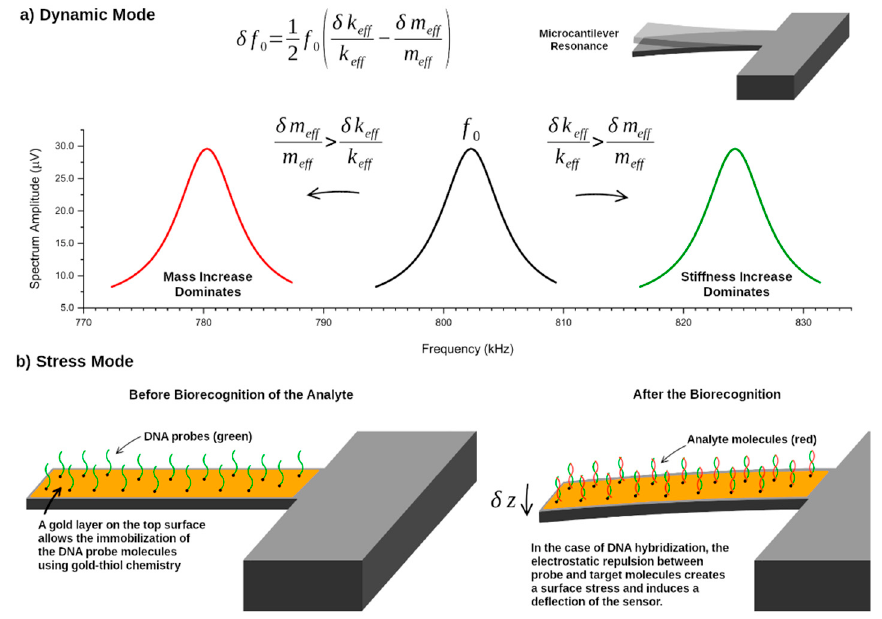
Figure 7. Mass sensing strategies. ( a ) Dynamic mode: the mass adsorbed on the surface of the cantilever causes changes in both its effective mass and stiffness, resulting in a shift in the resonance frequency, δ f 0 , to lower or higher values, depending on which effect dominates (red and green spectra). ( b ) Static deflection mode: the sensor deflects by a quantity δ z due to intermolecular interactions at the surface of the sensor. In the case of a DNA biosensing experiment, the surface stress is due to the electrostatic repulsion between the molecules at the surface when complementary DNA (red strands) hybridizes with the initially immobilized DNA probes (green strands).